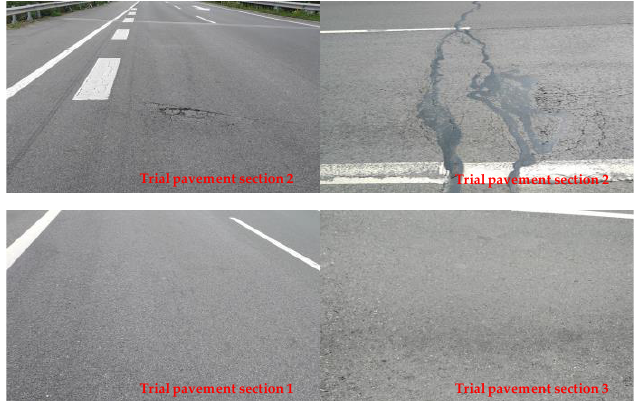
Figure 14. Representative disease photos of the trial sections.